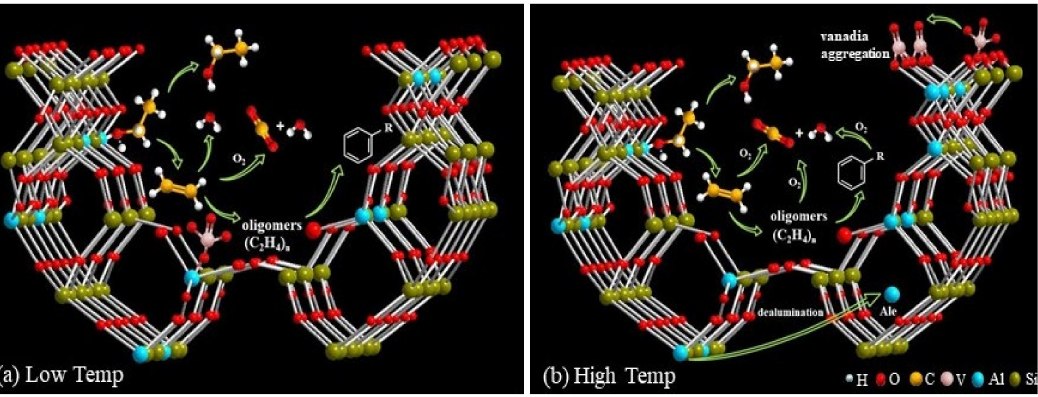
Figure 10. Schematic diagram for ( a ) the formation of coke on V 2 O 5 /NaY-SiO 2 and ( b ) dealumination concomitant with the aggregation of isolated VO